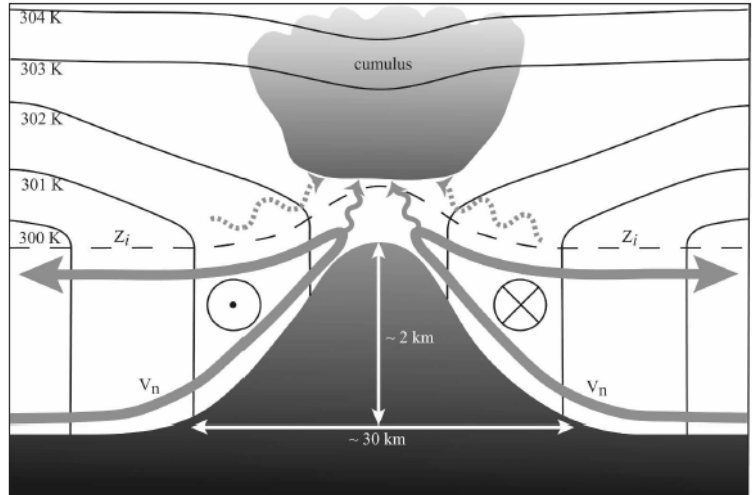
Figure 3. Schematic diagram of the low-level flow ( v n ) associated with a thermally forced daytime solenoidal circulation over a mesoscale mountain from Demko and Geerts [30]. Thin solid lines are isentropes, horizontal vorticity is shown as vectors into and out of the page, and z i denotes the ABL top. The cumulus cloud is fed in part by the solenoidal circulation and in part by horizontal convergence above the ABL. c (cid:13) American Meteorological Society. Used with